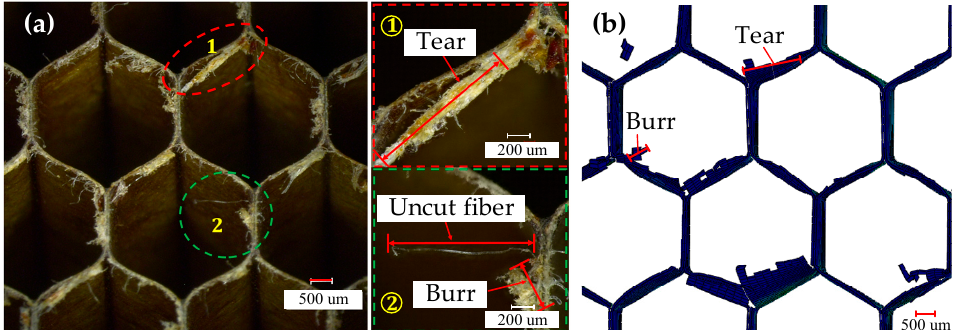
Figure 5. Comparison of damages from the ( a ) experiments and ( b ) FEM.